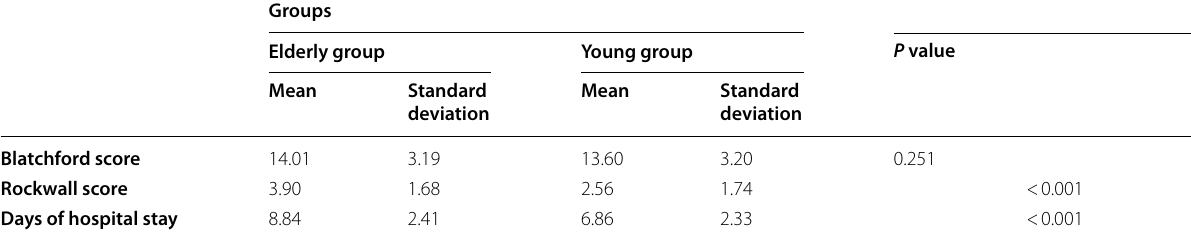
Table 7 Comparison between both groups regarding prognostic scores and days of hospital stay